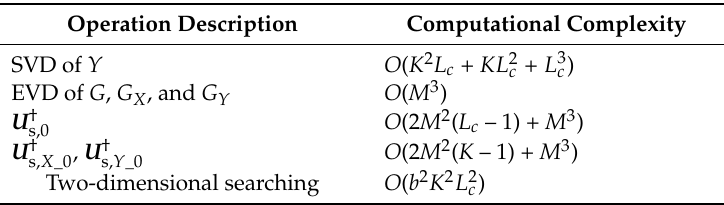
Table 1. Costs of individual